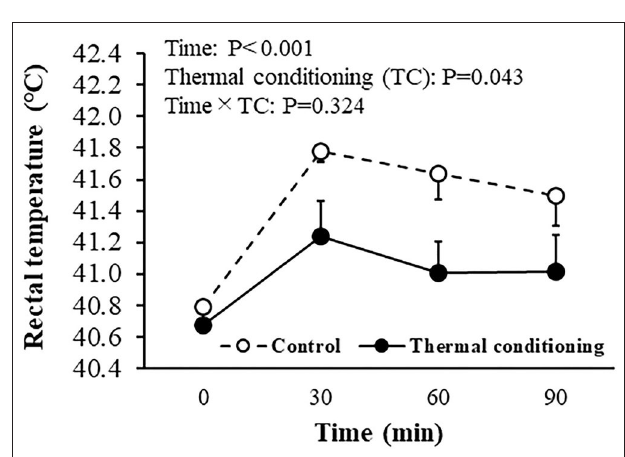
FIGURE 4 | Effect of thermal conditioning on rectal temperature during heat challenge in chicks. Open circles indicate the control group (no-thermal conditioning). Closed circles indicate the thermal conditioning group. The number of chickens in each group was n =